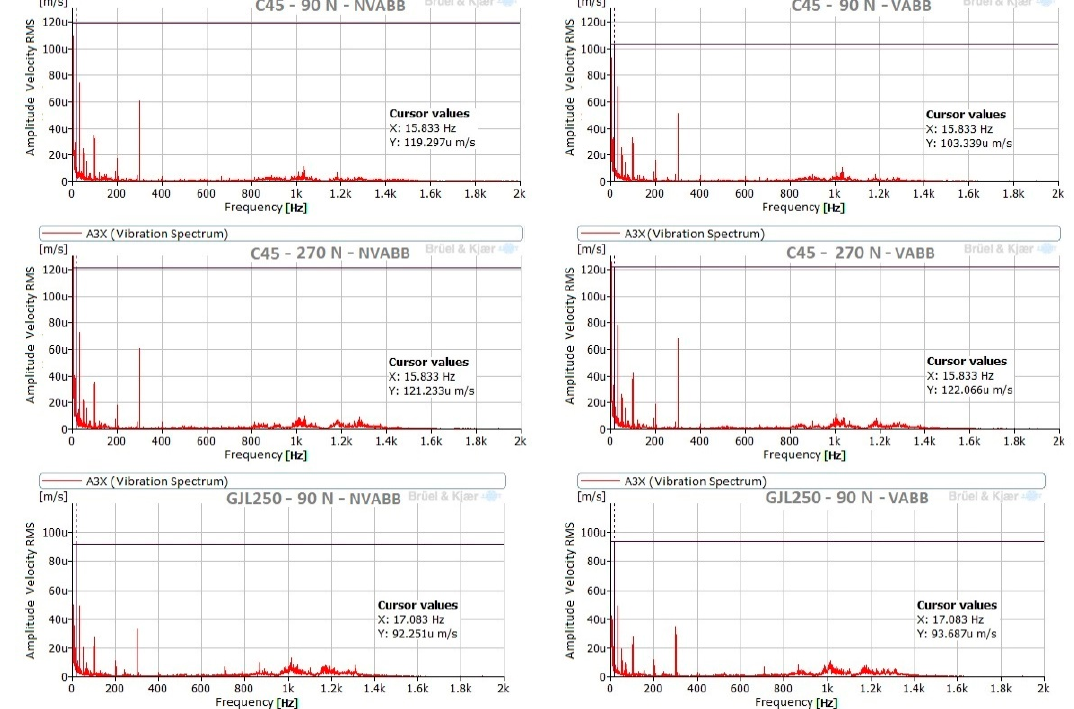
Figure 11. Measurements in burnishing without feed.